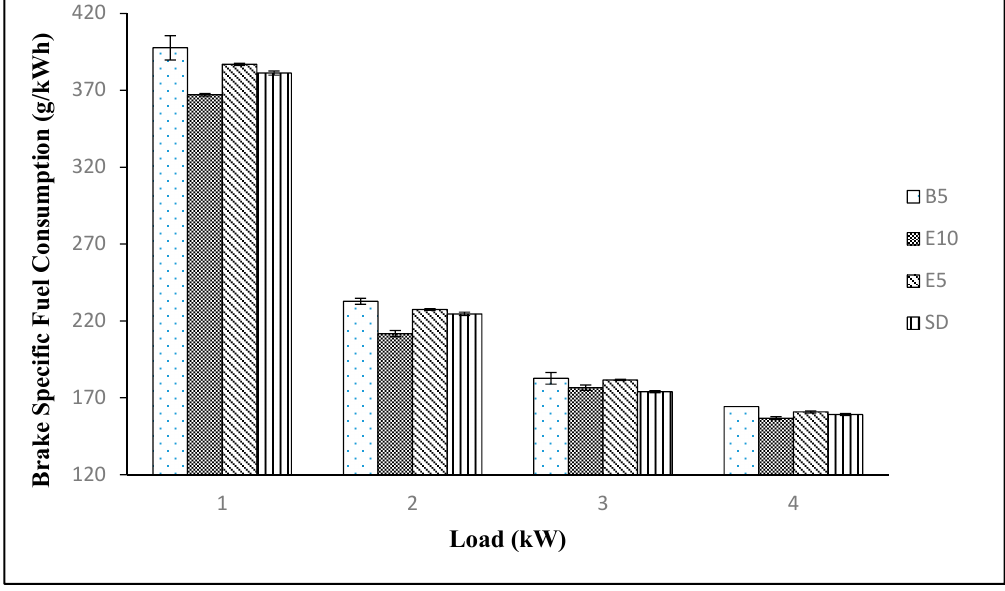
Figure 7. Brake specific fuel consumption versus load.